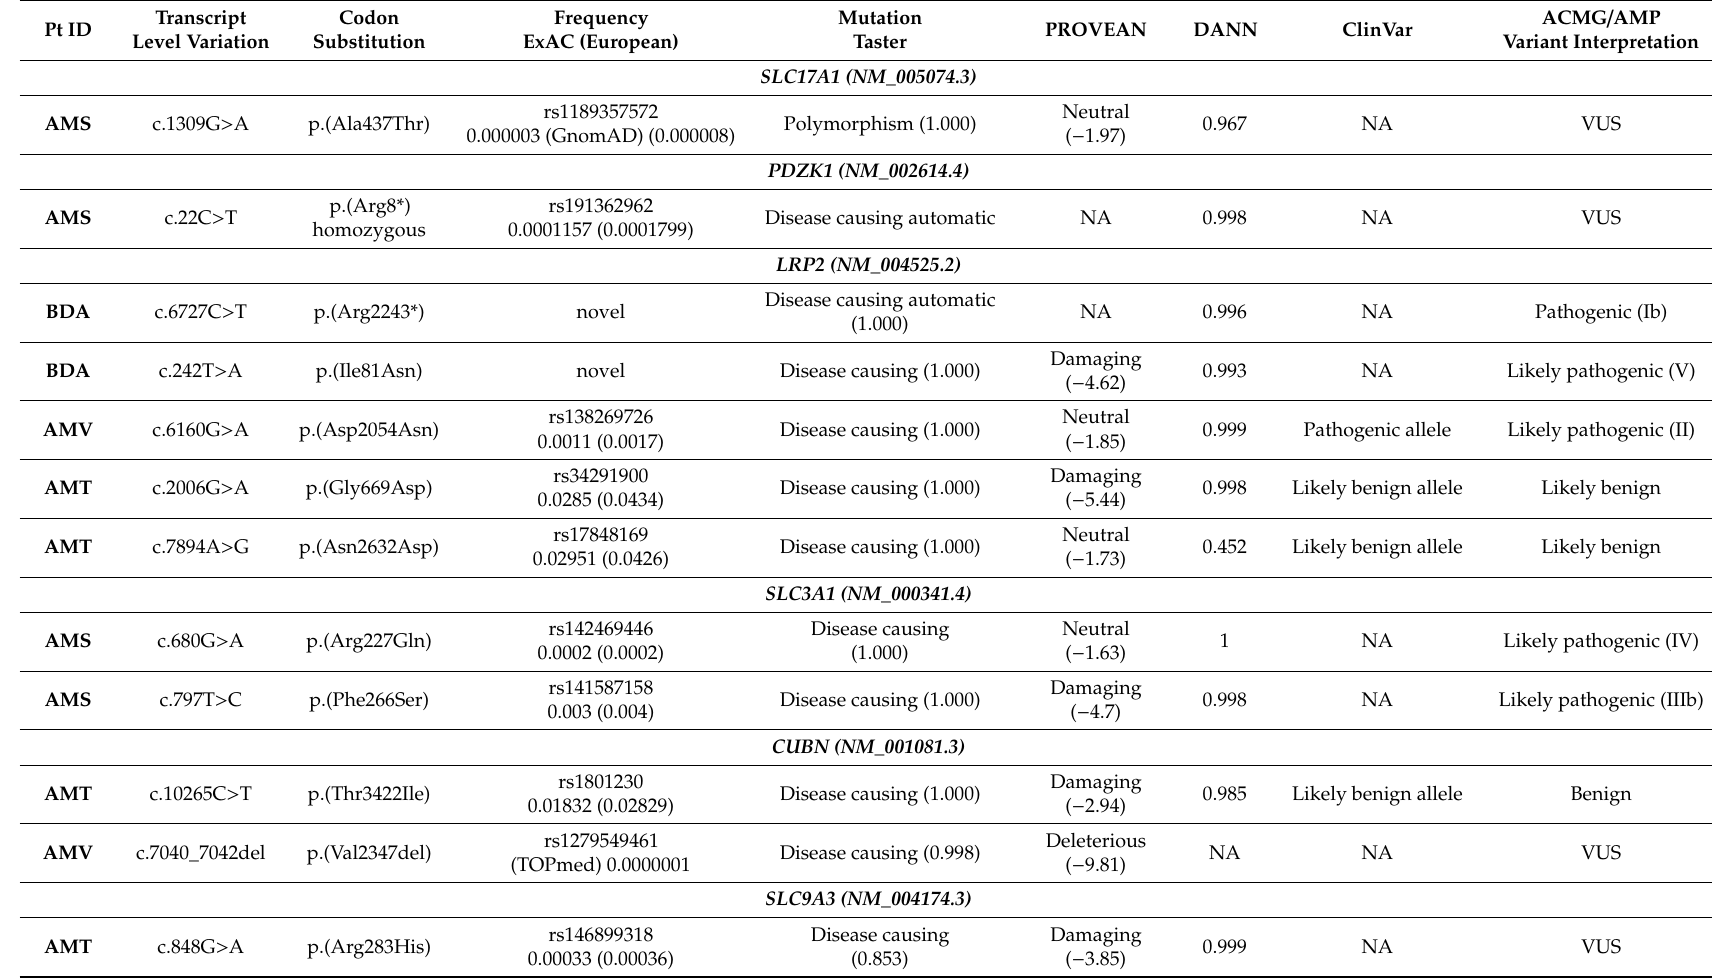
Table 3. Candidate variants for DD3 phenotypes detected by whole-exome sequencing